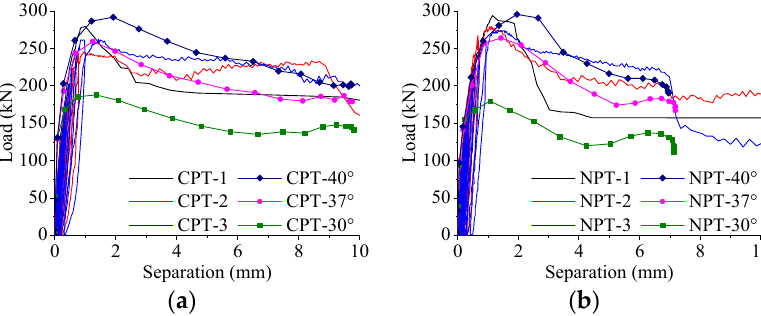
Figure 13. Tested and analyzed load–slip curves. ( a ) Conventional perfobond shear connector; ( b ) notched perfobond shear connector.